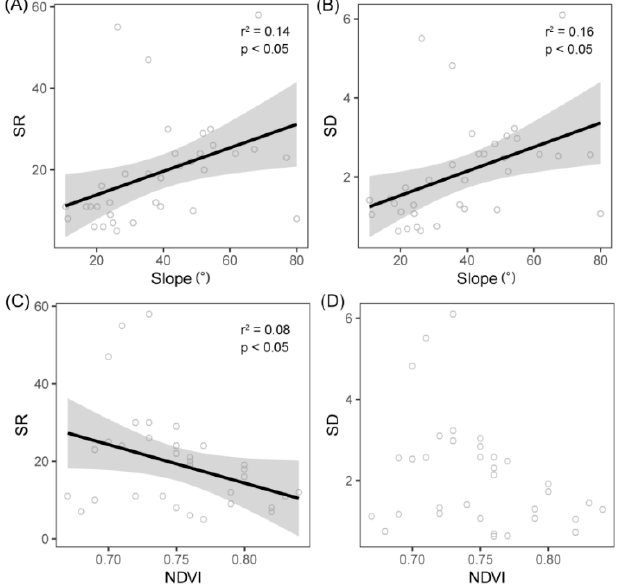
Figure 4. Linear relationships between species richness (SR) and species density (SD) with slope and normalized difference vegetation index (NDVI). ( A ) relationship between SR and slope; ( B ) relationship between SD and slope; ( C ) relationship between SR and NDVI; ( D ) relationship between SD and NDVI.